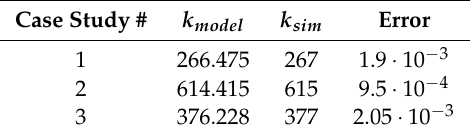
Table 3. Values of k model and k sim for each case